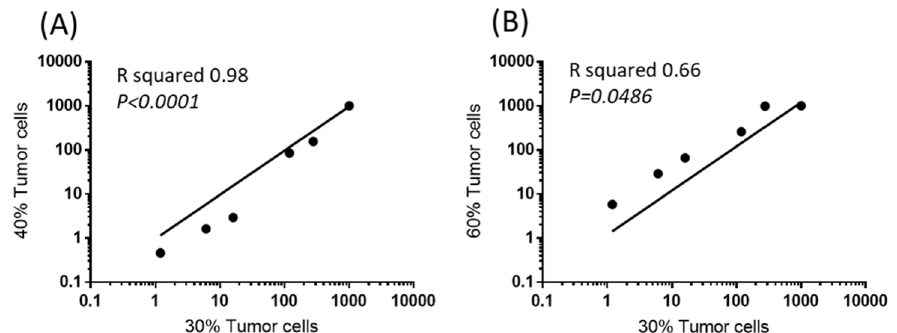
Figure 5. Sores of expression of 6/9 target genes as a function of tumor cell content. Cross correlation of the expression levels (scores) in a sample region containing 30% tumor cells with other regions of the same sample containing 40% ( A ) or 60% tumor cells ( B ).